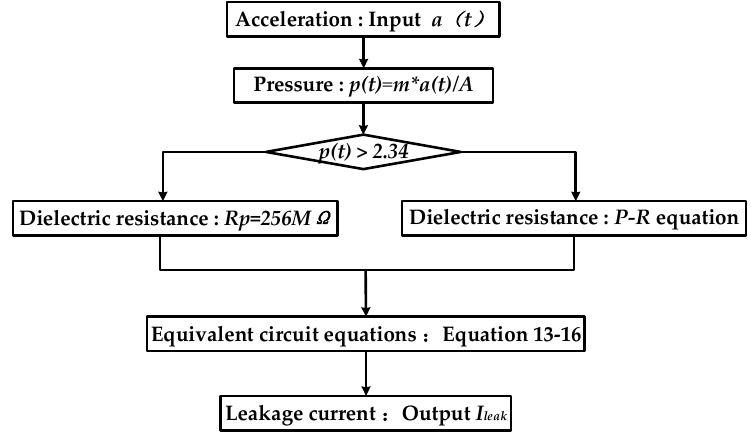
Figure 14. Flow chart of the leakage current calculation.